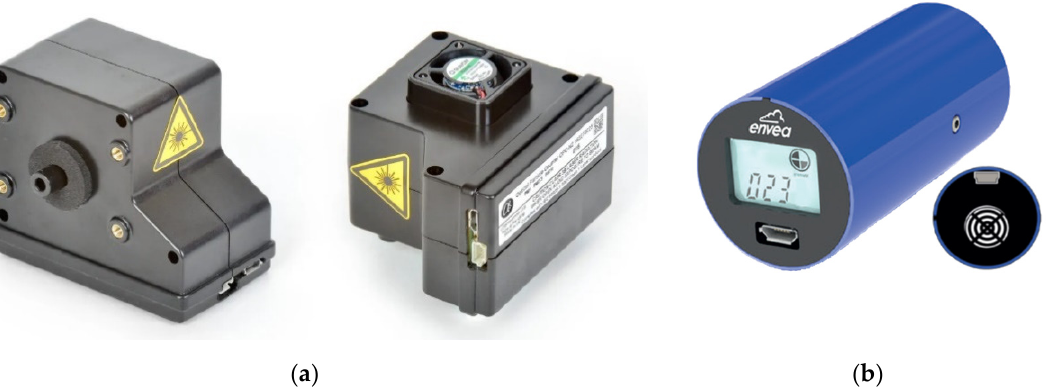
Figure 2. External view of the ( a ) Alphasense OPC-N3 sensor, approximate dimensions of 75 × 64 × 60 mm and ( b ) the Cairsens© sensor, approximate dimensions of 65 mm length and 33 mm diameter, inserted view of the bottom part with air intake.